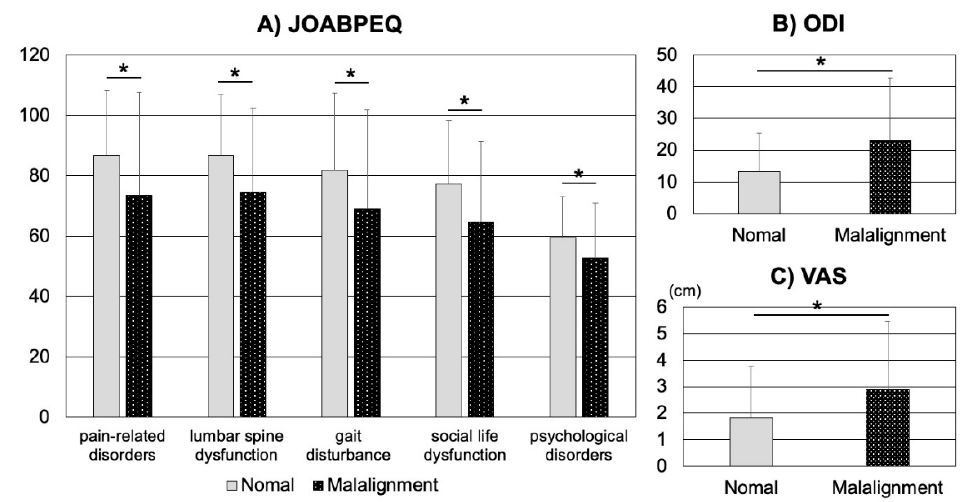
Figure 1. In patients without VFs, comparisons of ( A ) age, ( B ) BMD, ( C ) BAP, and ( D ) TRACP5b values determined in patients of the normal alignment and sagittal malalignment groups are shown. VF, vertebral fracture; N.S.: not significant; BMD, bone mineral density; BAP, bone-specific alkaline phosphatase; TRACP5b, tartrate-resistant acid phosphatase 5b.